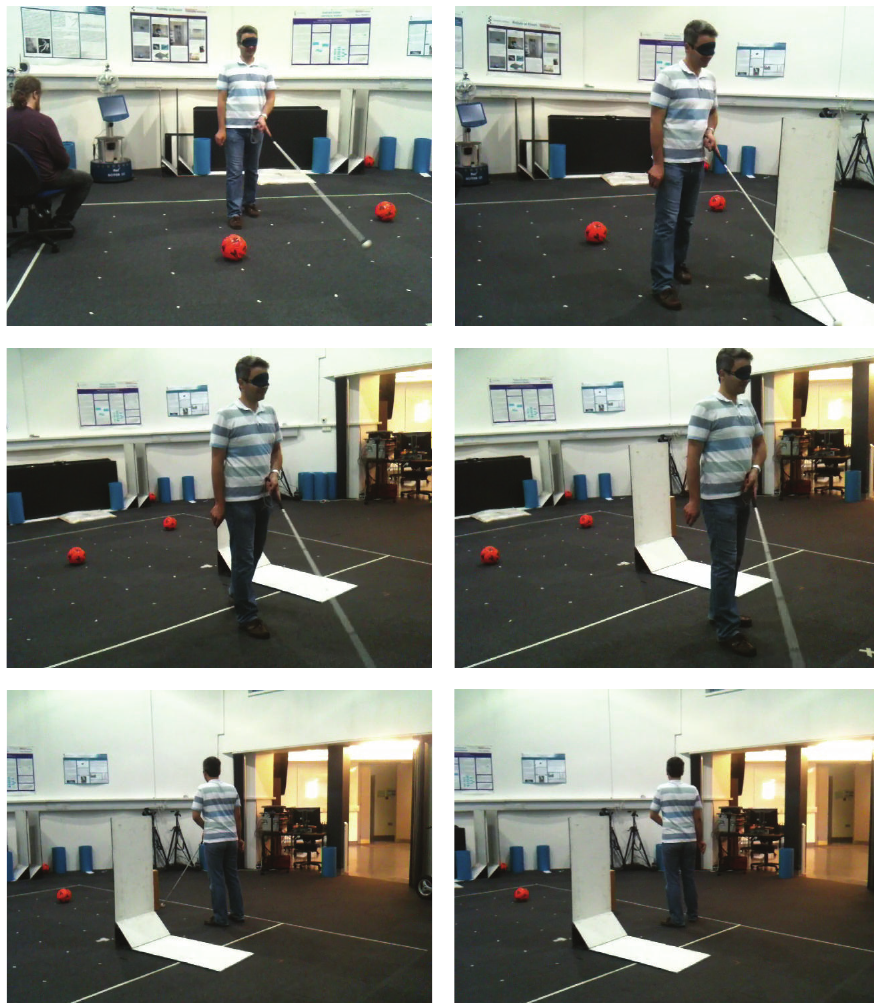
Figure 10: A blindfolded person using white cane as mobility aid.